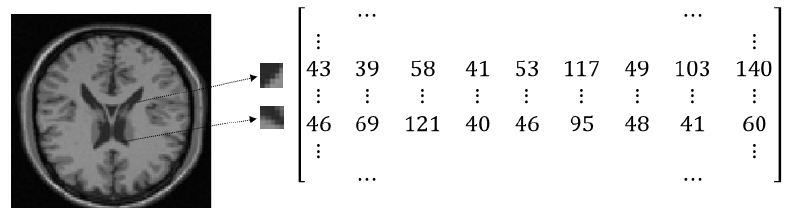
Figure 4. Matrix representation of a point cloud in high dimensional space; For an image of size 200 × 200 and patch size of 3 × 3, the matrix is 40,000 × 9.